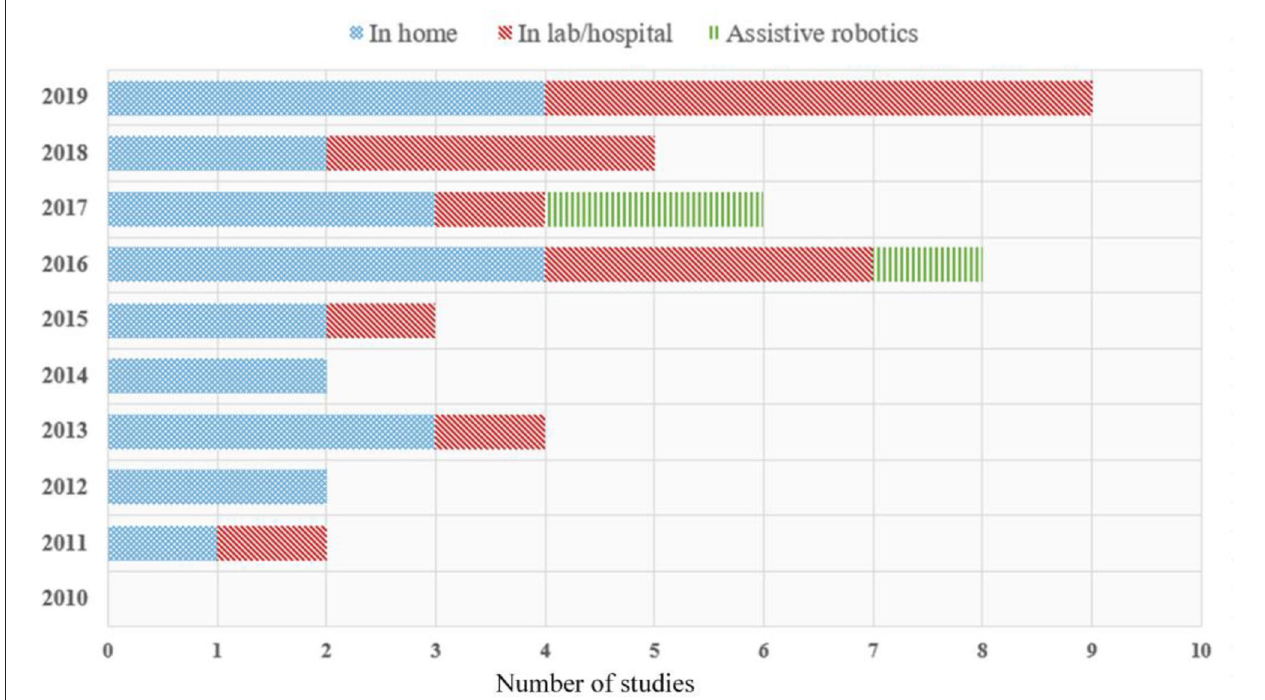
FIGURE 2 | Distribution of selected research papers according to publication year.